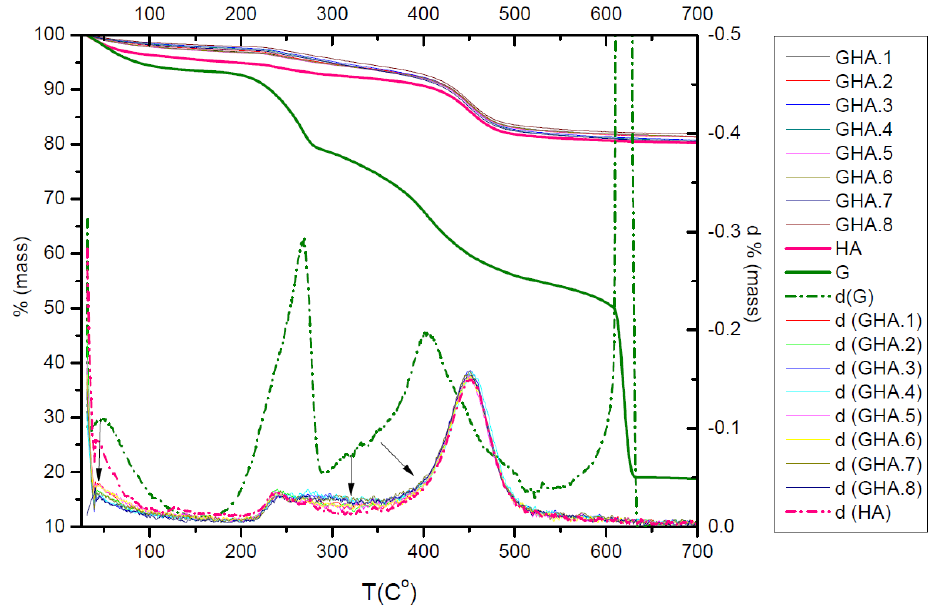
Figure 15. TGA–DTA diagram of halloysite (HA), chlorophyll (G) and the synthesized hybrid pigments GHA for the different conditions [1_8].